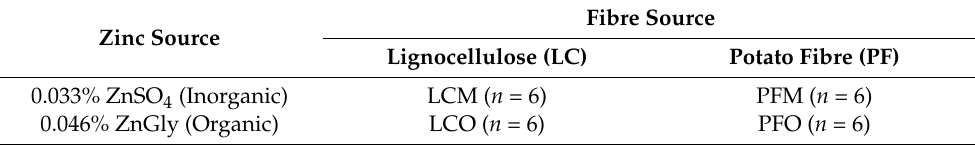
Table 2. Experimental